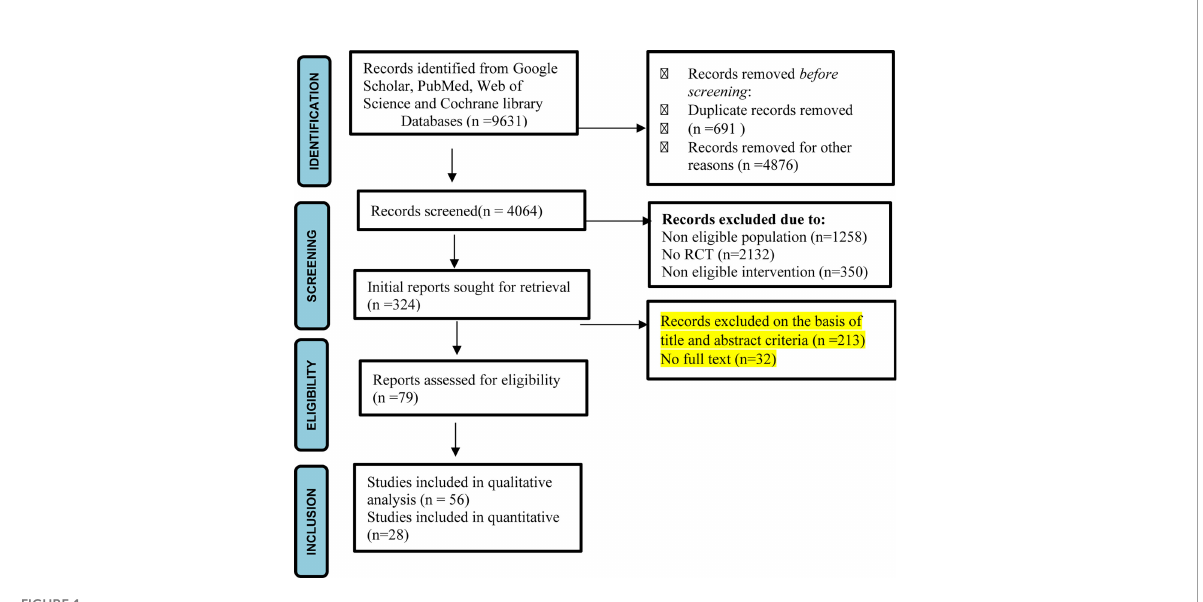
FIGURE 1 PRISMA fl ow diagram of study